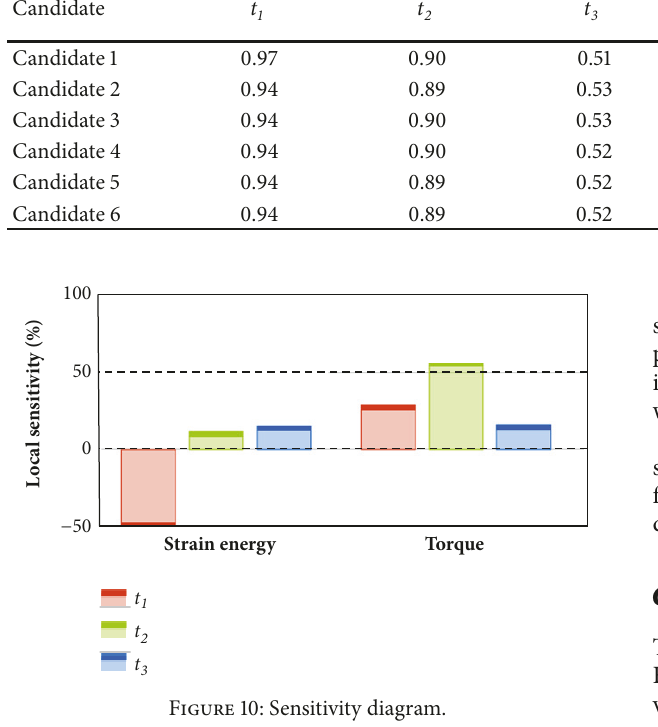
Figure 10: Sensitivity